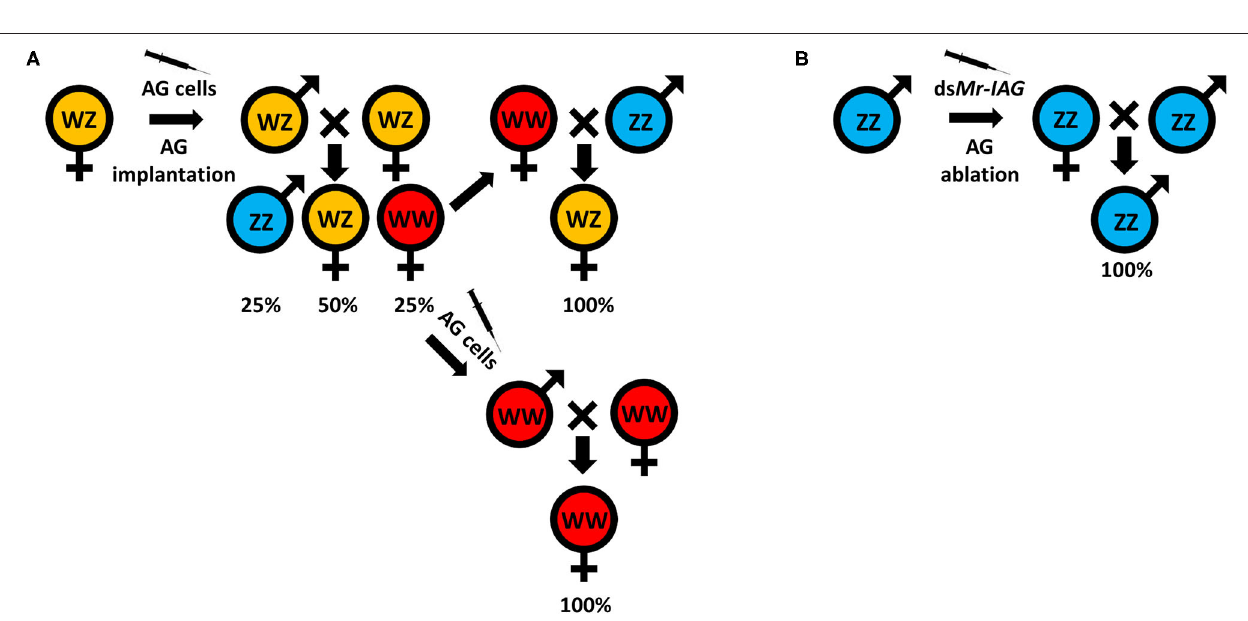
FIGURE 3 | Successful sex manipulations in M. rosenbergii . (A) A WZ female implanted with an AG (20) or injected with an AG cell suspension (22) inverted into a WZ “neo-male.” The progeny, when crossed with normal WZ females, yielded 25% of WW females. These WW females can be crossed with normal ZZ males to produce all-female WZ populations, or they can be injected with an AG cell suspension (42) to produce WW neo-males that, when crossed with WW females, will give rise to all-female WW populations. (B) ZZ males that are AG ablated (85) or injected with ds Mr-IAG (86) inverted into ZZ “neo-females” that, when crossed with normal ZZ males, give rise to all-male ZZ